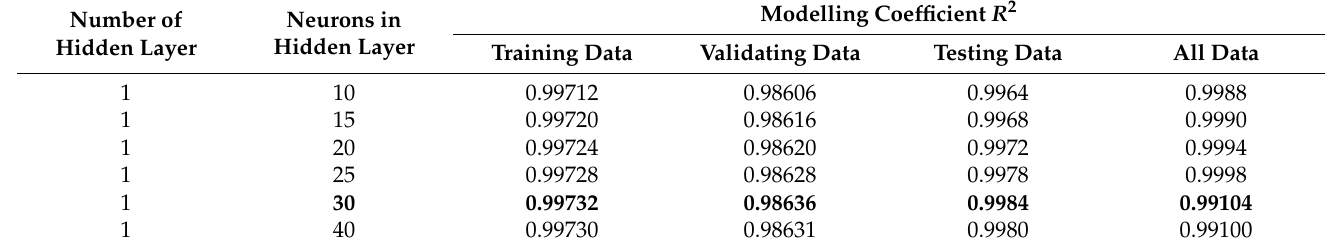
Figure 24. Optimal performance was found at 30 neurons in the hidden layer.